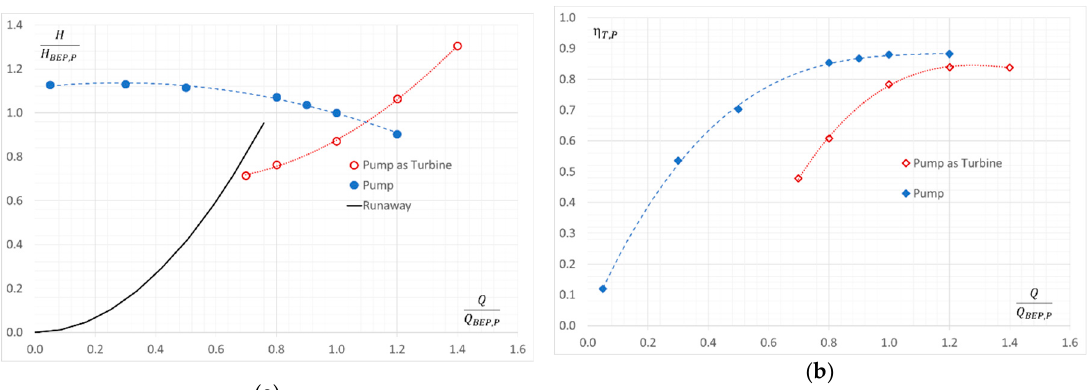
Figure 16. Plot of the hydraulic turbo machine performance in both pump and turbine operating modes: ( a ) head curves calculated with Equation (5) with runaway curve; ( b ) Efficiency calculated with Equations (6) and (7).